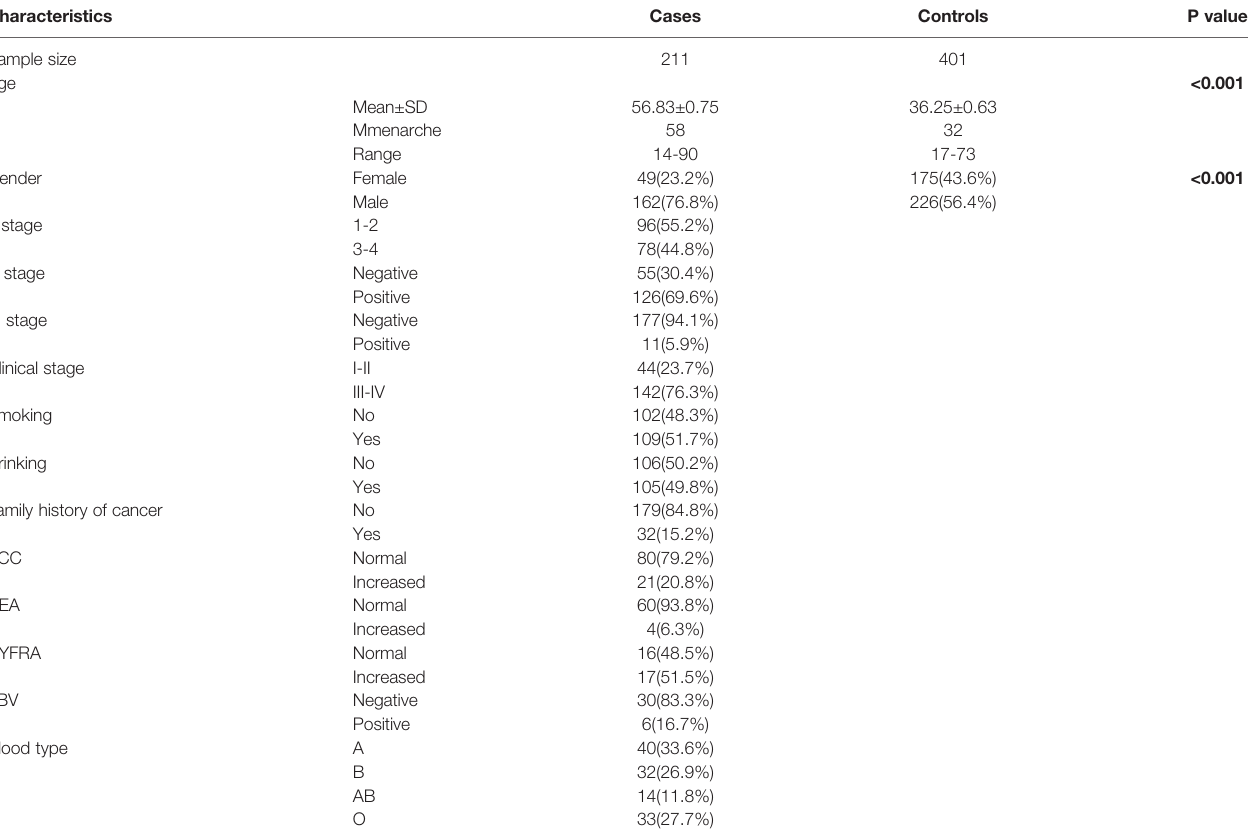
TABLE 1 | The baseline characteristics of the